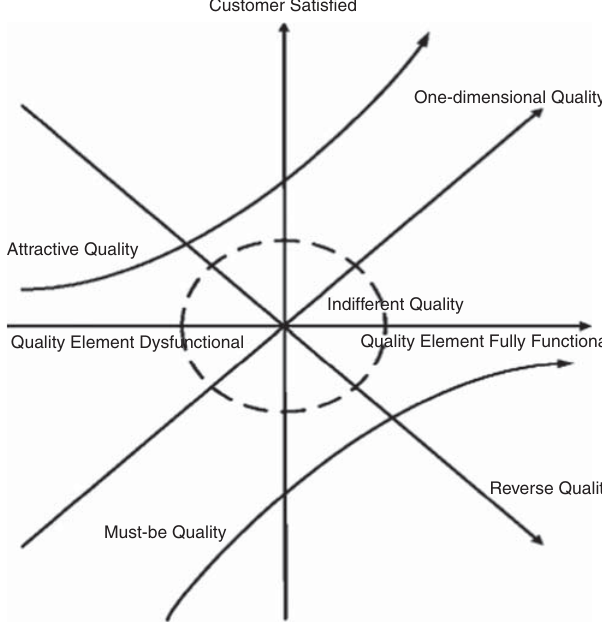
Figure 2. Kano ’ s